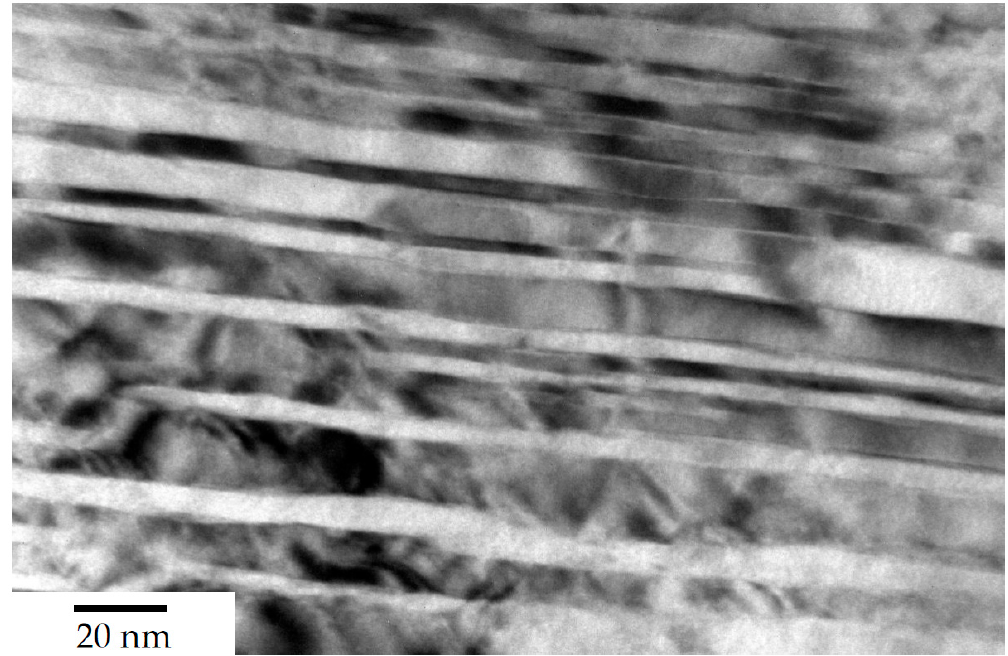
Figure 6. HRTEM image of fine bainitic microstructure of steel A0, heat treated according to route ③ . Showing individual bainitic ferrite plates and some particles of retained austenite. When observed in bright field mode the bainitic ferrite plates ( α ) appear light, and the retained austenite ( γ ) dark.